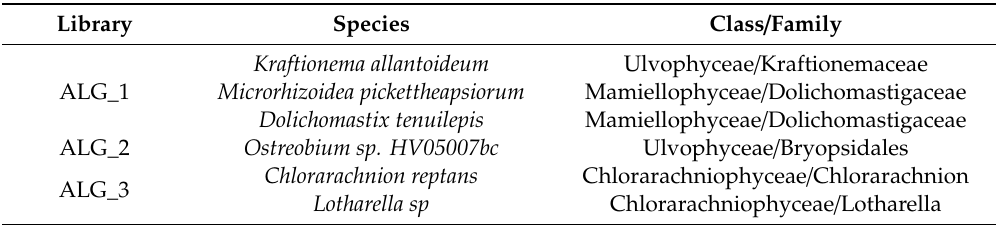
Table 1. Sample and library